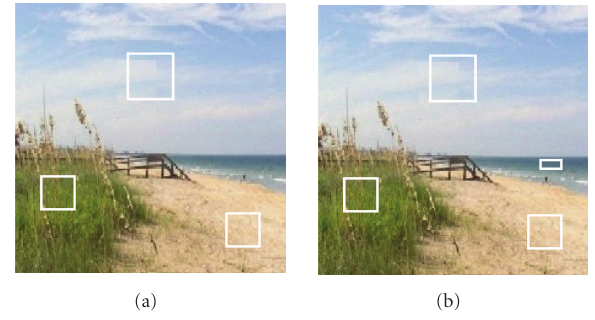
Figure 2: Examples of (a) a 3-phase supervision and (b) a 4-phase supervision to break the symmetry in the model. Such weak super- vision can also be automated based on multiscale patch statistics [1,